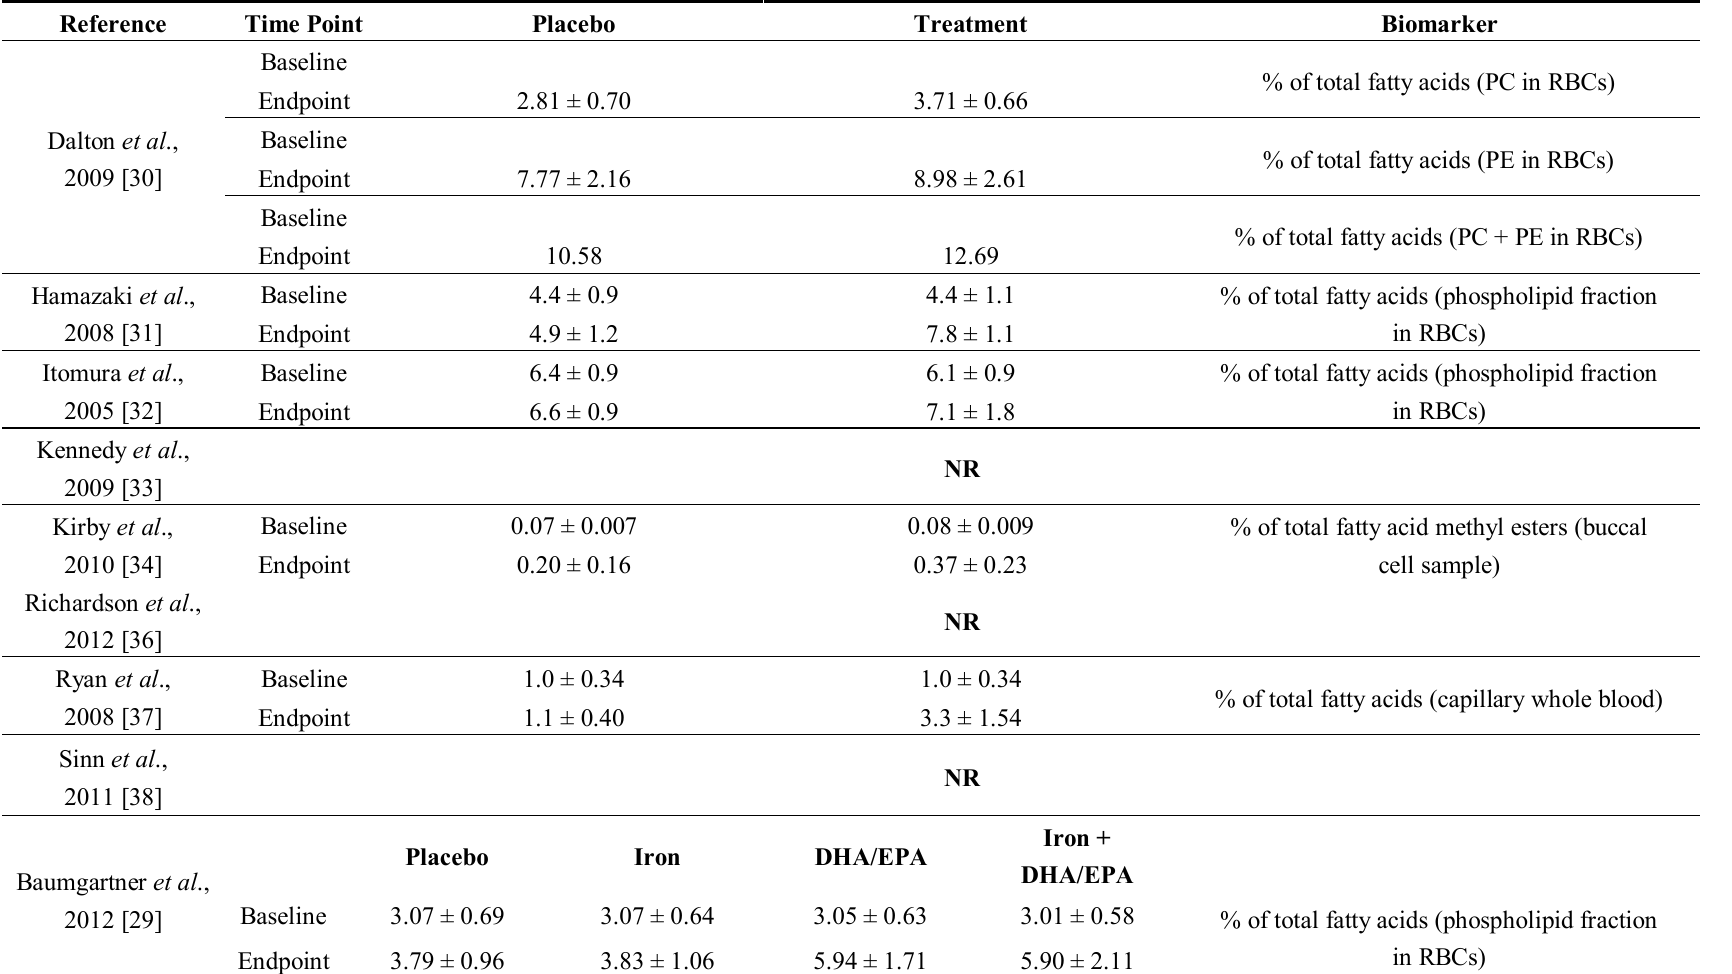
Table 3. DHA status reported in clinical trials of DHA supplementation in